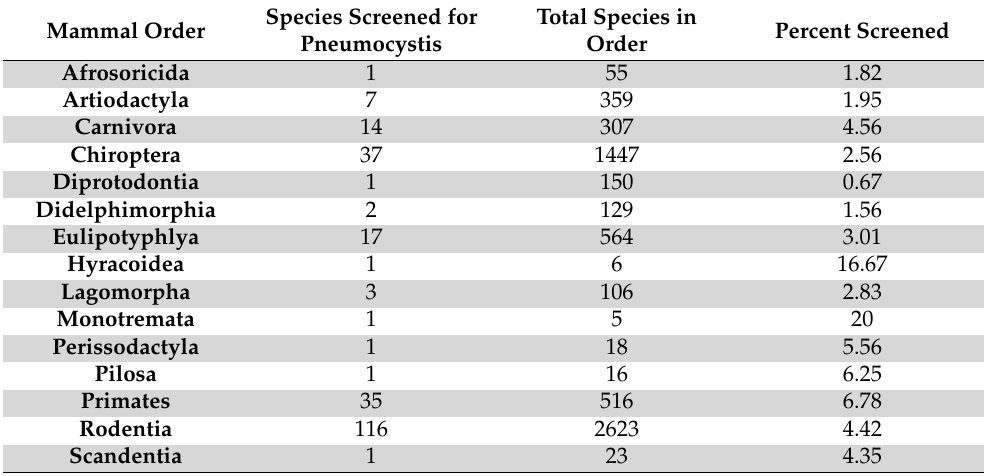
Table 3. Number of species screened per sampled mammal order. The 12 unsampled mammal orders are not